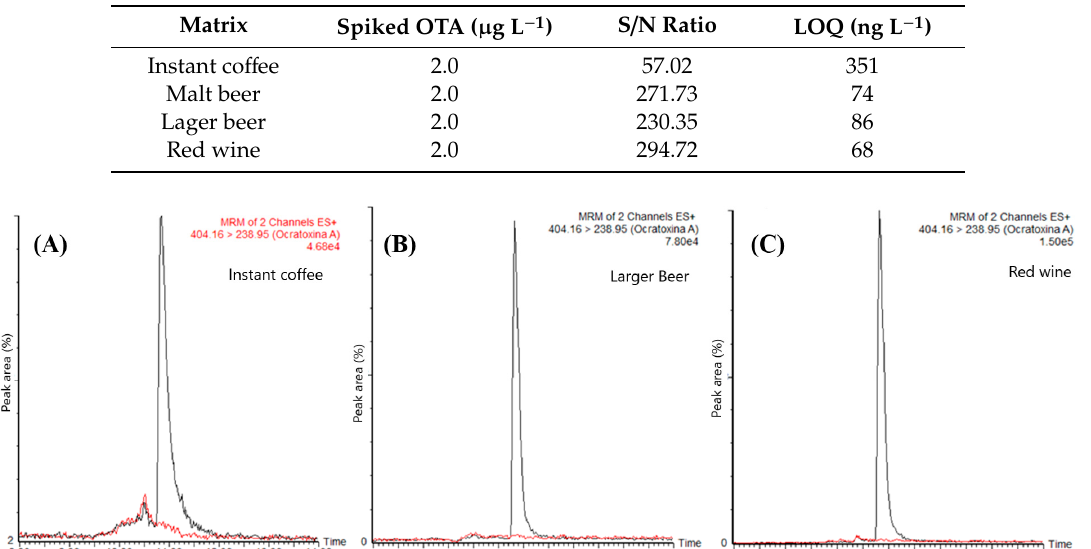
Table 1. Evaluation of the OTA m / z 404.1 → m / z 238.9 ion transition response as a function of the analyzed matrix.